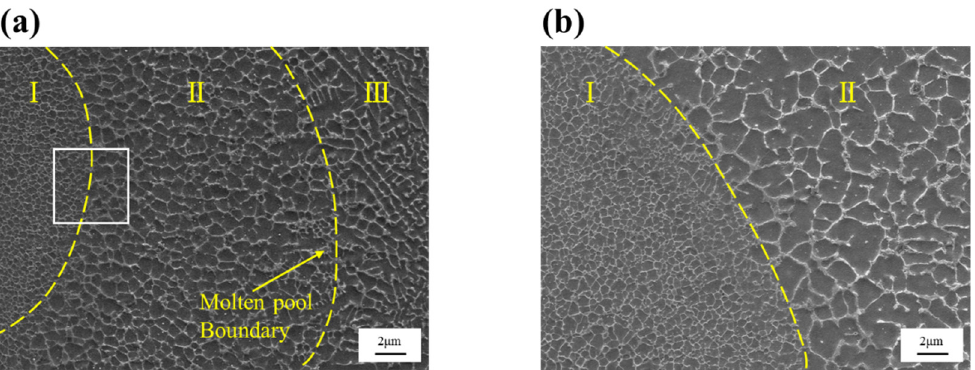
Figure 5. Microstructure of SLM-fabricated composites: ( a ) the three different regions (I, II and III) within a melt pool, and ( b ) the boundary between regions I and II.